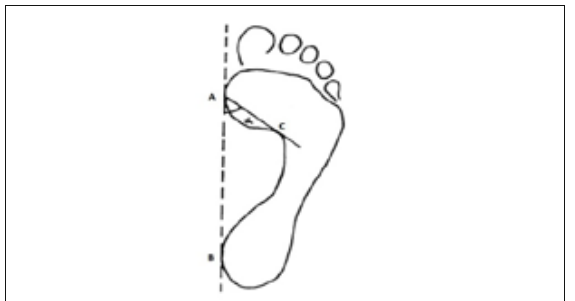
Figure 4. The Clarke’s angle (Onodera et al., 2008) Arch index by D. S. Williams (WAI) is dorsum height (DORS) divided by arch length (AL). Dorsum height was measured from the floor to the top of the foot at 50% of foot length. Foot length (FL) was measured from the most posterior portion of the calcaneus to the end of the longest toe. Arch length was measured from the most posterior portion of the calcaneus to the center of the first metatarsophalangeal joint. For Williams method, arch height was measured with the digital photographic method (Pohl, Farr, 2010). The MLA is classified as follows: ³ 0.357 – high arch; 0.356– 0.275 – normal and ≤ 0.274 is low MLA (Williams, Mc Clay., 2000).